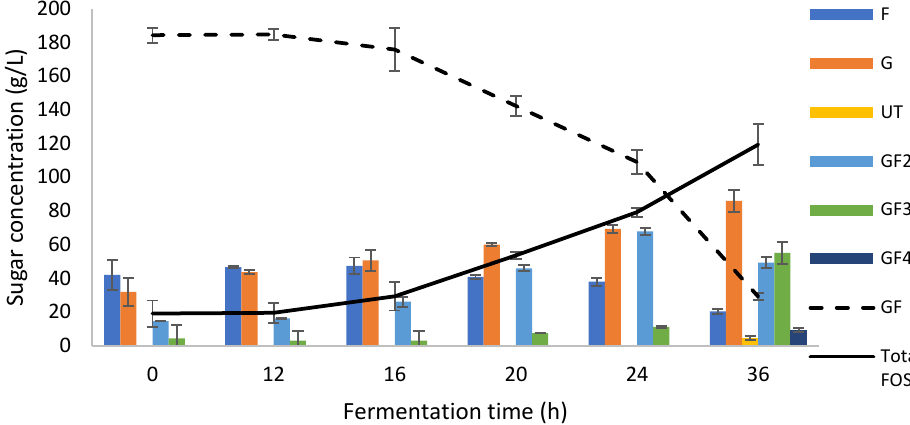
Figure 3. Fructooligosaccharides (FOS) production during fermentation under optimized conditions using AgMe media in shaking flasks. Fructose (F), glucose (G), sucrose (GF), unidentified compound, probably a trisaccharide (UT), kestose (GF2), nystose (GF3), 1-Fructofuranosyl nystose (GF4).